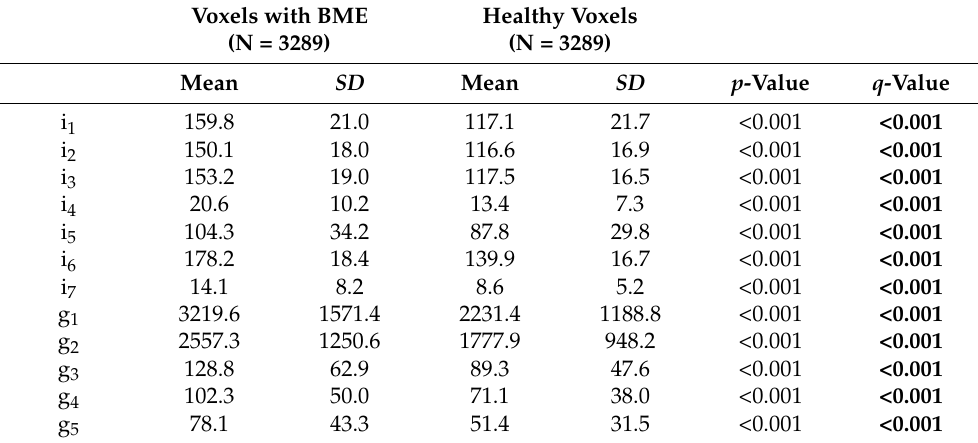
Table 4. Textural features of voxels in bone marrow edema and healthy voxels. Mean values and standard deviation (SD) of features extracted from MR images of voxels in bone marrow edema (BME) and healthy voxels. Differences in feature values for pathological and healthy voxels were examined using linear mixed-effects models. p -values and Bonferroni corrected p -values (q-values) are reported. Significant values (<0.05) after Bonferroni in